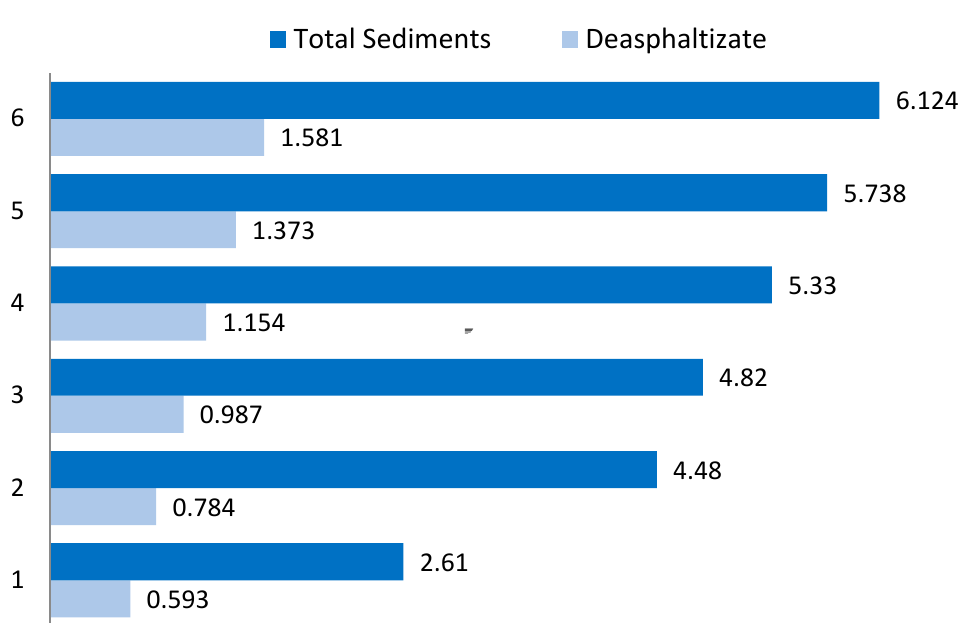
Figure 5. Reduction of sulphur in the deasphaltisation depending on the sulphur content in the fuel mixture.